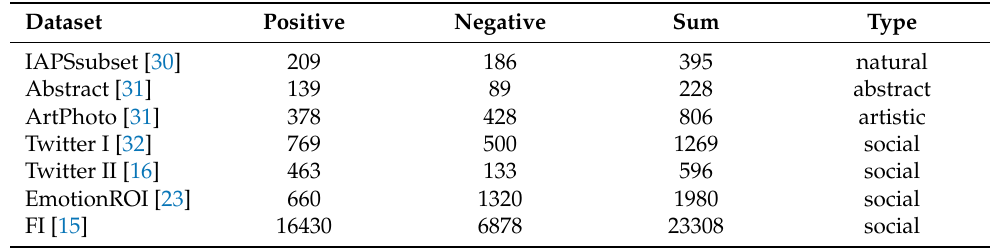
Table 1. Seven commonly used visual sentiment analysis datasets. Most datasets are from social networks. Except for FI dataset, the others are relatively small datasets, because of the subjective and labor-intensive labeling